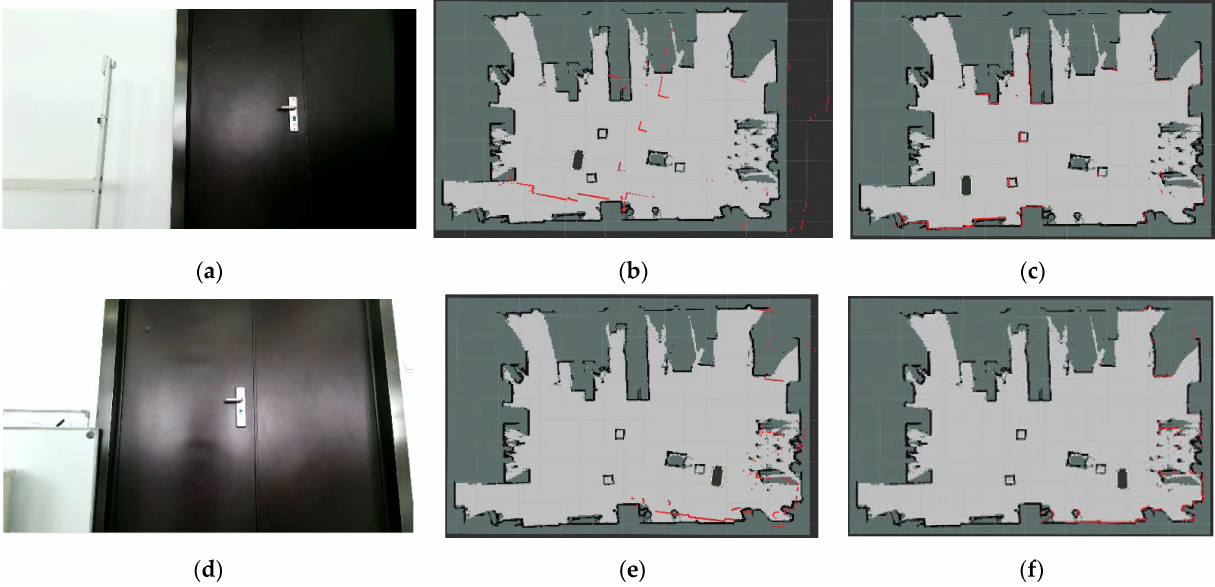
Figure 19. ( a – c ) are the images obtained by the camera, the coarse positioning of vision and the accurate relocation result fused with laser information at test point 1, respectively; ( d – f ) are the results of test point